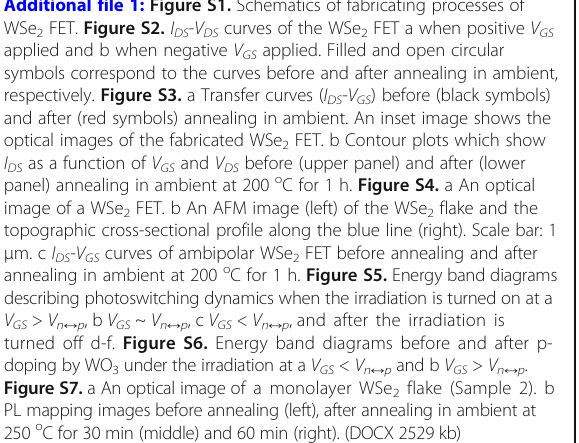
Additional file 1: Figure S1. Schematics of fabricating processes of WSe 2 FET. Figure S2. I DS - V DS curves of the WSe 2 FET a when positive V GS applied and b when negative V GS applied. Filled and open circular symbols correspond to the curves before and after annealing in ambient, respectively. Figure S3. a Transfer curves ( I DS - V GS ) before (black symbols) and after (red symbols) annealing in ambient. An inset image shows the optical images of the fabricated WSe 2 FET. b Contour plots which show I DS as a function of V GS and V DS before (upper panel) and after (lower panel) annealing in ambient at 200 o C for 1 h. Figure S4. a An optical image of a WSe 2 FET. b An AFM image (left) of the WSe 2 flake and the topographic cross-sectional profile along the blue line (right). Scale bar: 1 μ m. c I DS -V GS curves of ambipolar WSe 2 FET before annealing and after annealing in ambient at 200 o C for 1 h. Figure S5. Energy band diagrams describing photoswitching dynamics when the irradiation is turned on at a V GS > V n ↔ p , b V GS ~ V n ↔ p , c V GS < V n ↔ p , and after the irradiation is turned off d-f. Figure S6. Energy band diagrams before and after p- doping by WO 3 under the irradiation at a V GS < V n ↔ p and b V GS > V n ↔ p . Figure S7. a An optical image of a monolayer WSe 2 flake (Sample 2). b PL mapping images before annealing (left), after annealing in ambient at 250 o C for 30 min (middle) and 60 min (right). (DOCX 2529 kb)